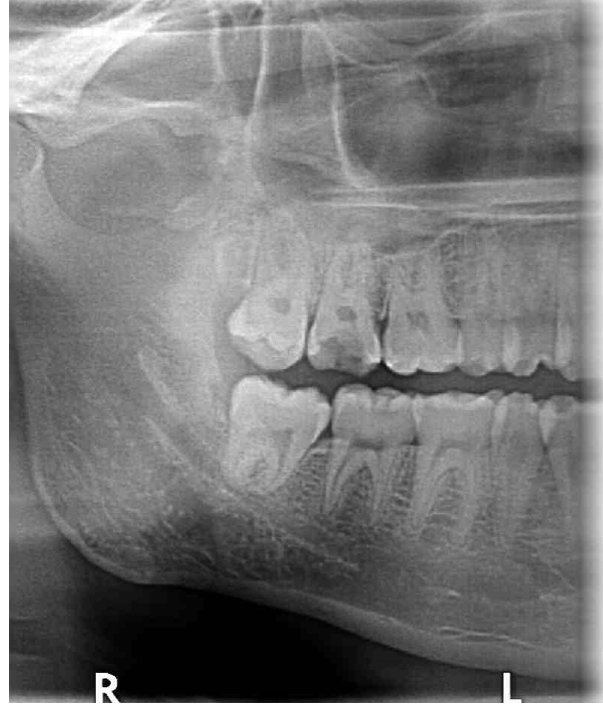
Fig. 6. Signs of normal bone formation in the sectional